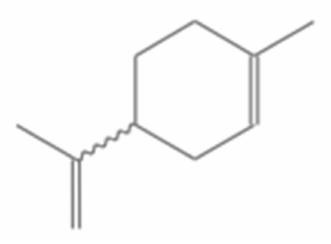
Figure 3. Chemical structure of